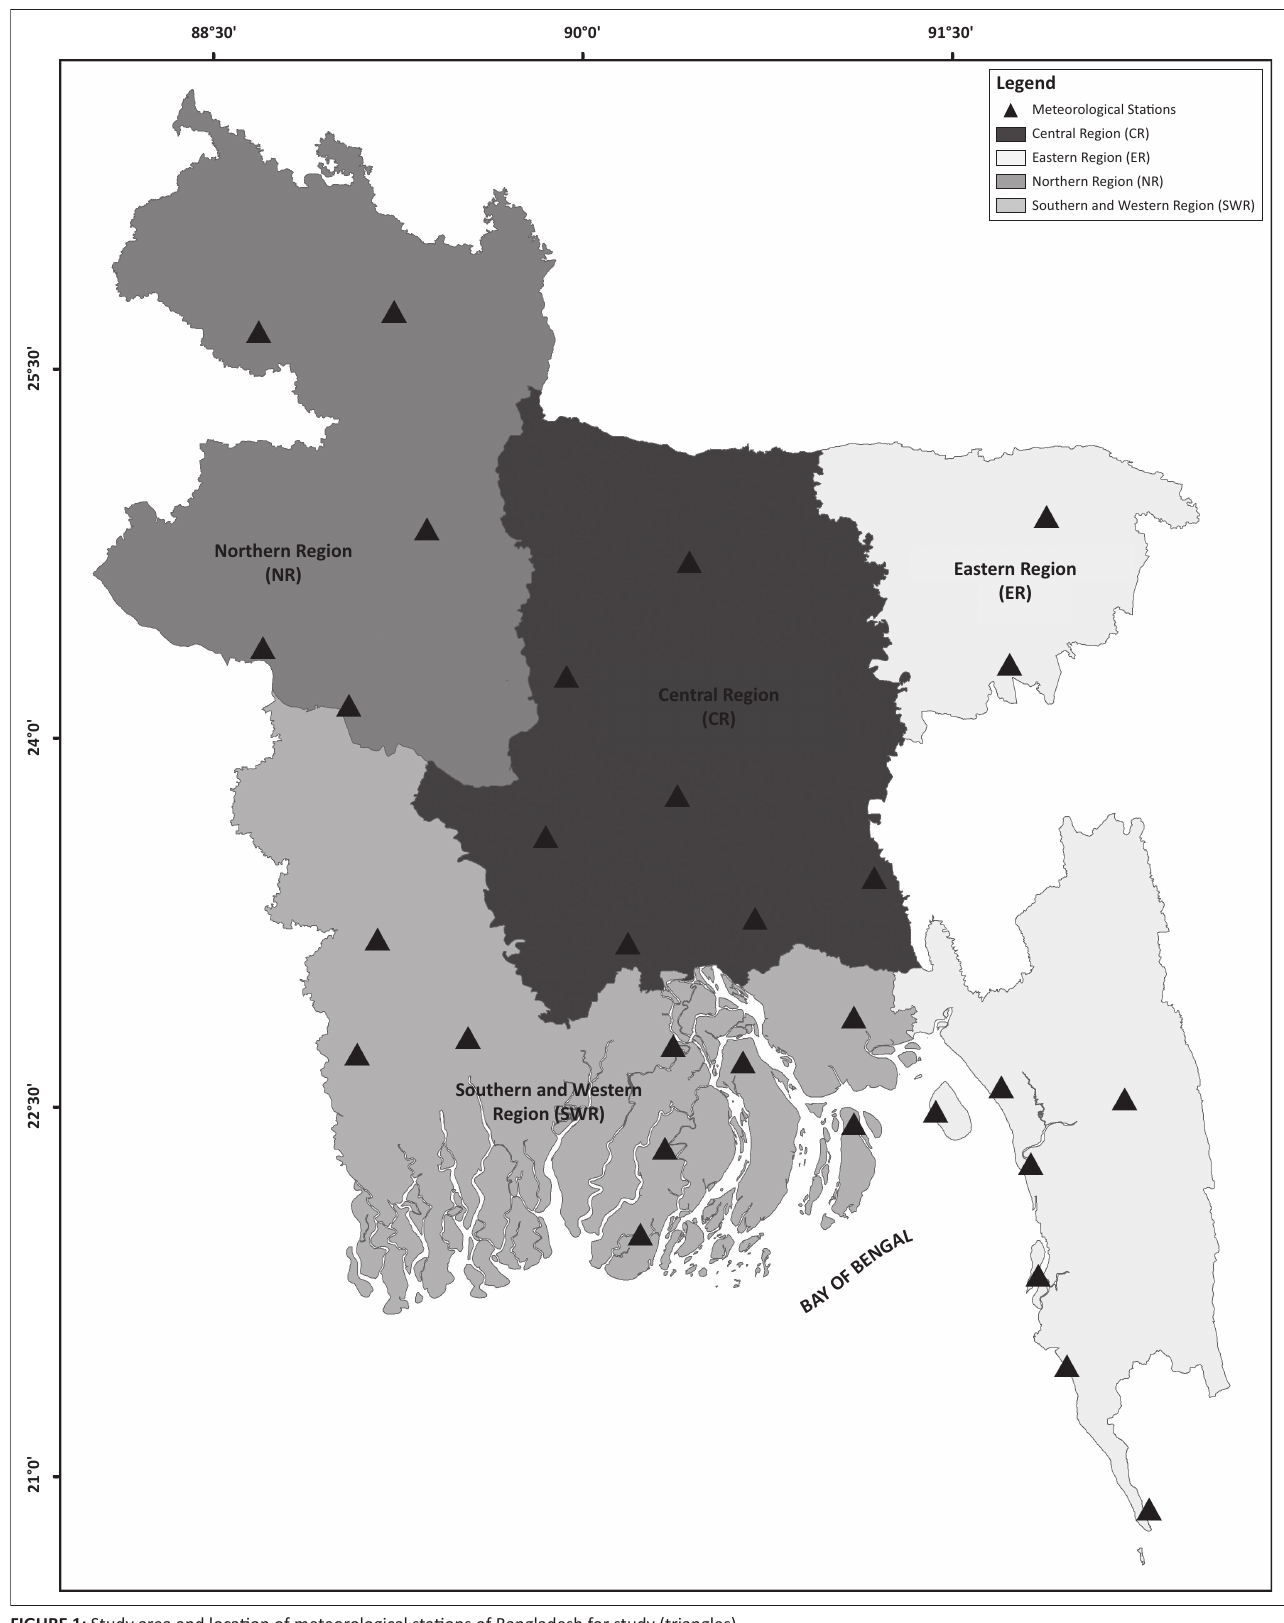
FIGURE 1: Study area and location of meteorological stations of Bangladesh for study